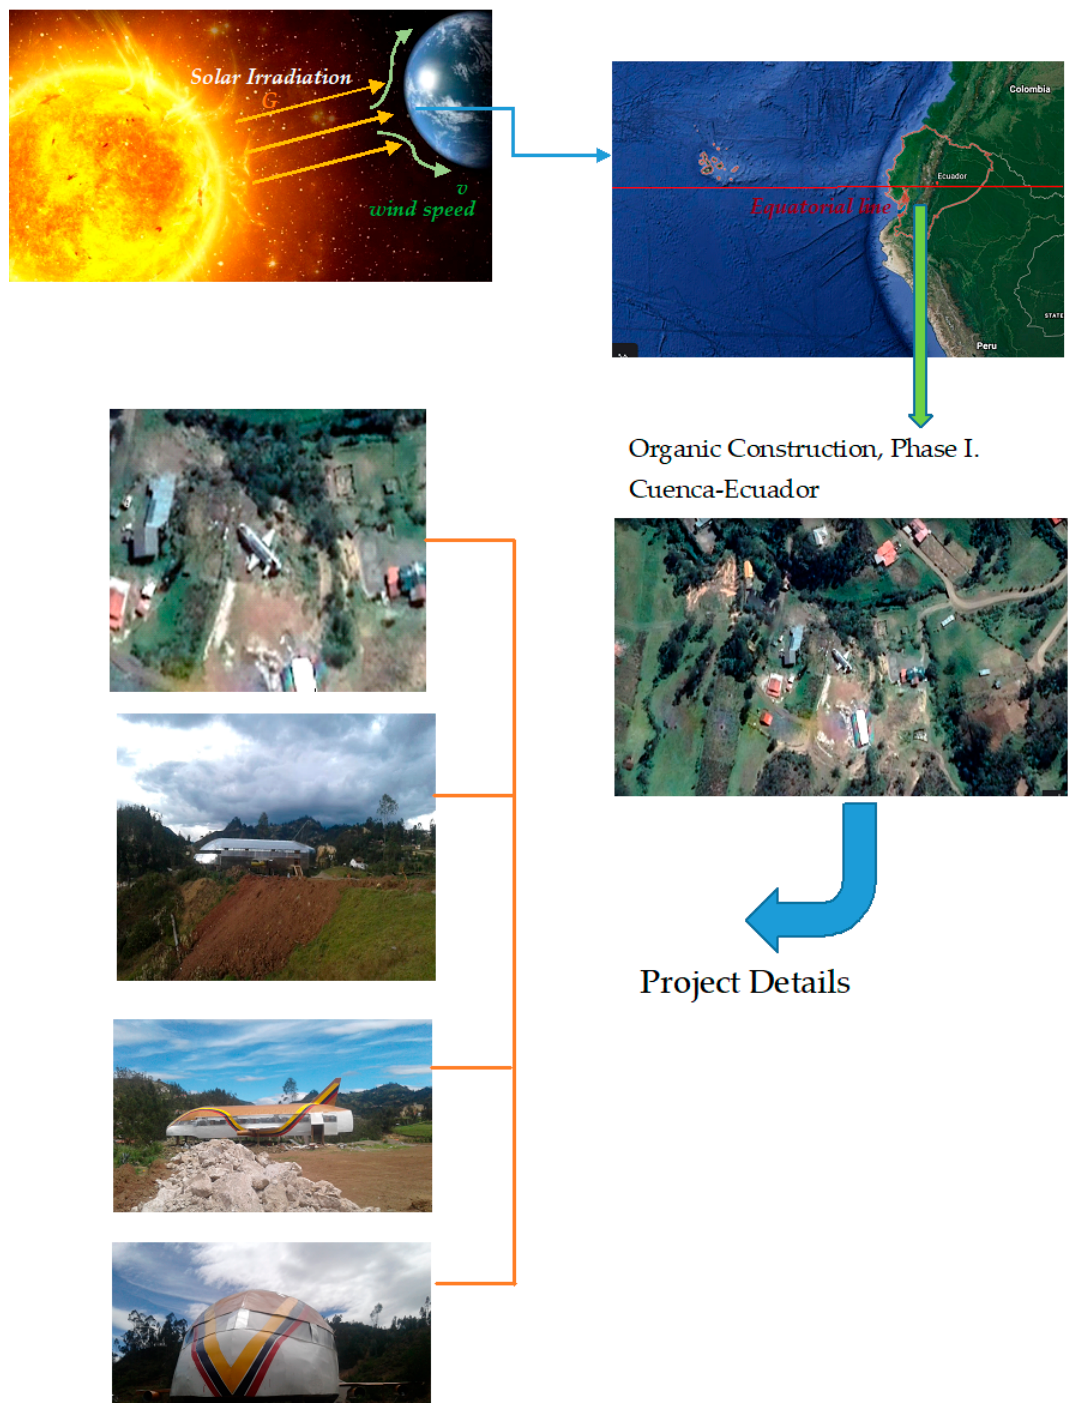
Figure 17. Referential diagram after energy conversion by hybrid systems in organic construction.